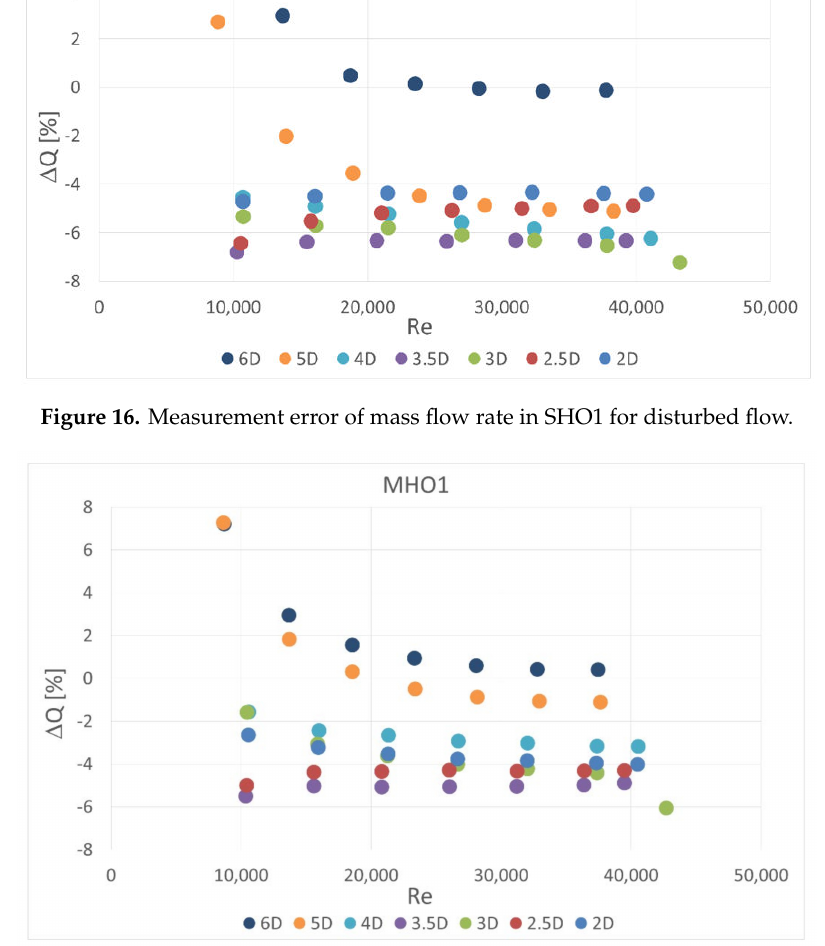
Figure 17. Measurement error of mass flow rate in MHO1 for disturbed flow.